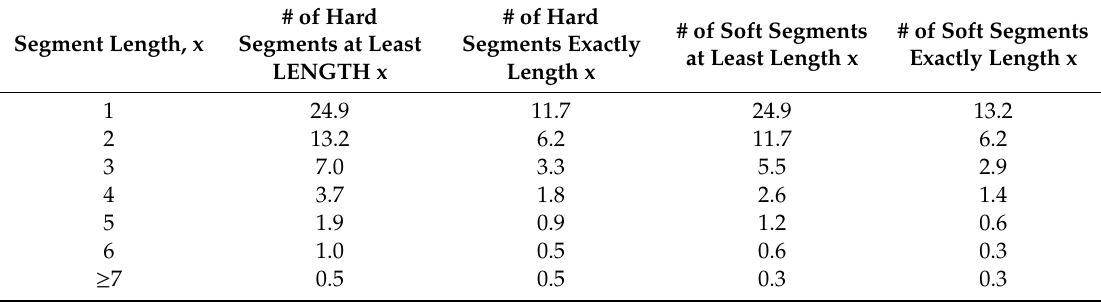
Table 3. Segment length